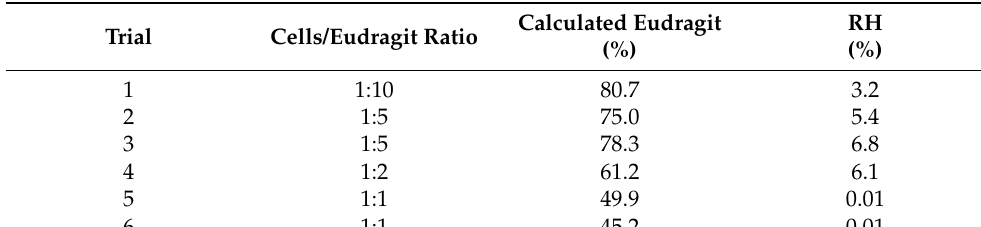
Table 1. Results of relative humidity (RH) and correct coating amount calculated by the TGA process for each coating attempt.